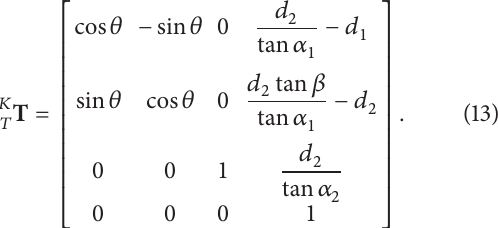
Figure 3: Coordinate system of the glass-handing robot.